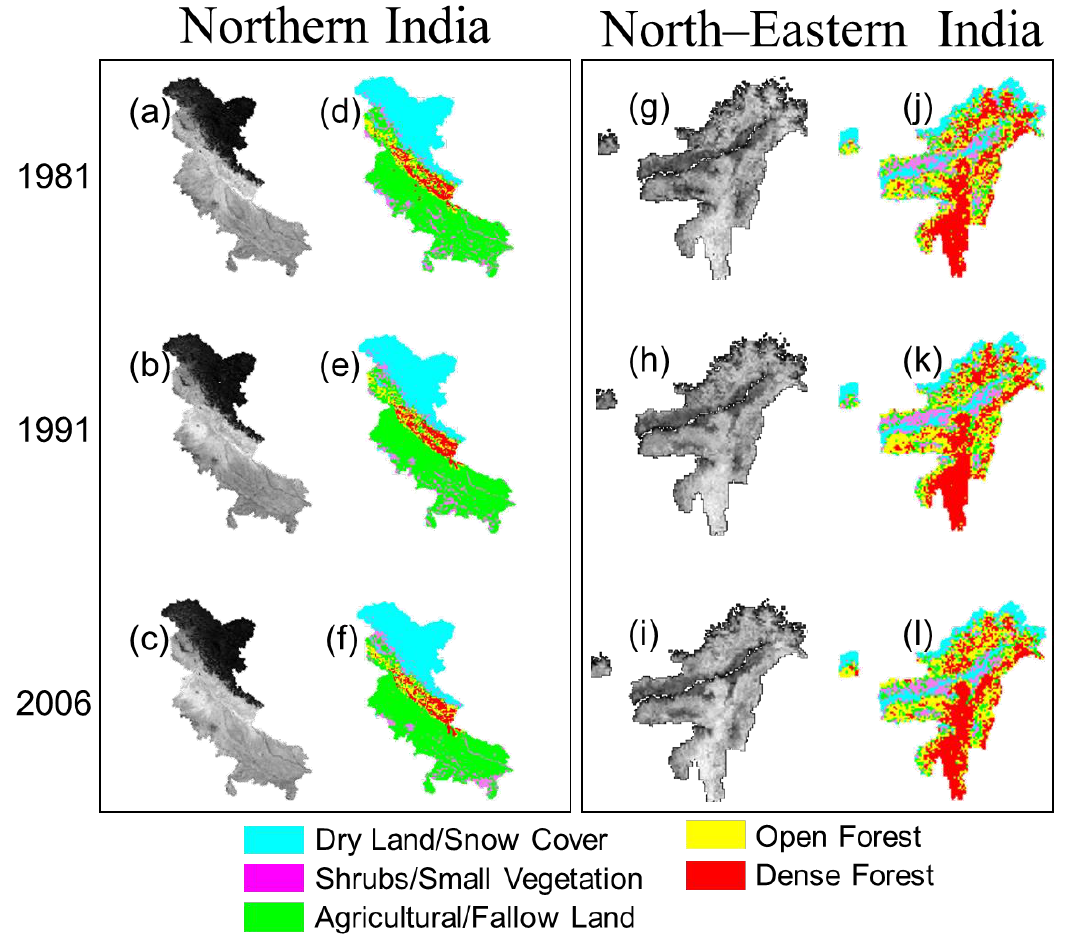
Figure 4. Spatial representation of land-use over NI (left panel) and NEI (right panel) for the years 1981, 1991 and 2006 from ( a – c , g – i ) advanced very high-resolution radiometer (AVHRR) normalized difference vegetation index (NDVI) images and from ( d – f , j – l ) land-use and land cover (LULC) classification.